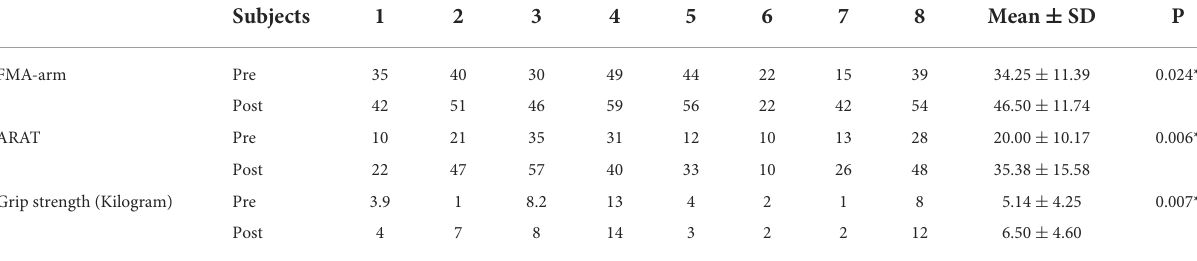
TABLE 7 FMA-arm score, ARAT score and Grip strength score of all the subjects ( n = 8).